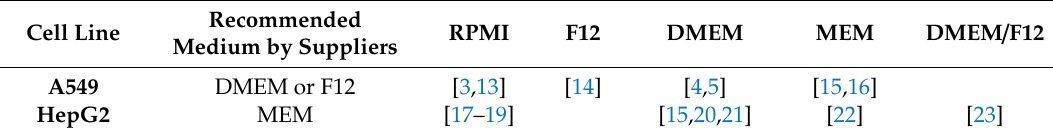
Table 2. Variation in media selection for the same cell